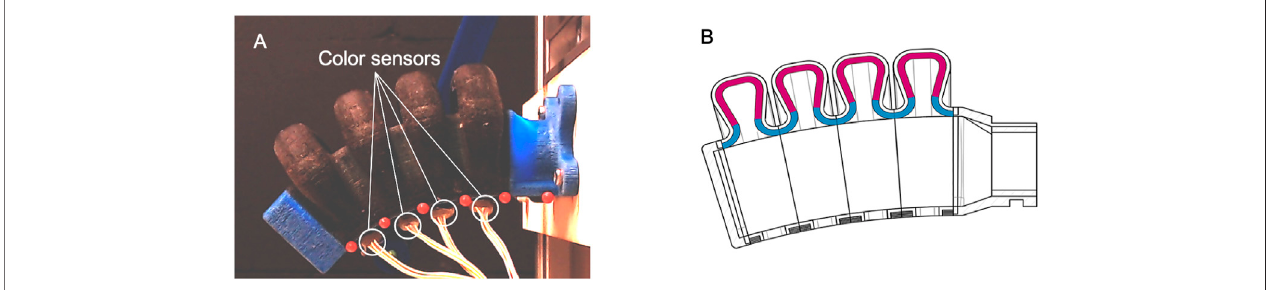
FIGURE 3 | (A) Sensorized Soft actuator embedded with four color sensors and six red markers on the inextensible layer. (B) Illustration demonstrating the signal transducing color pattern inside the actuator ’ s air chamber.